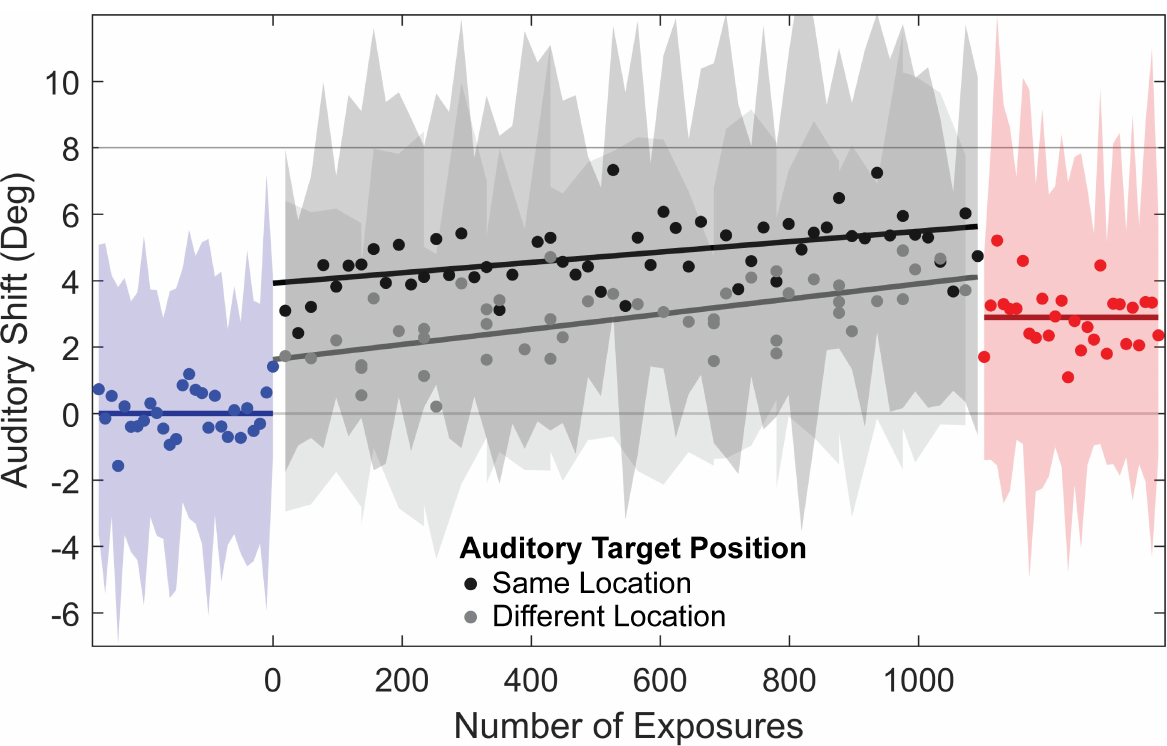
Fig 3. Evolution of auditory shift with repeated exposure to fixed AV disparity, averaged across subjects. Blue and red points represent average relative error for pre-disparity and post-disparity, respectively. Black and gray points represent average relative error while localizing auditory targets during the exposure block, with black indicating localization of auditory targets presented 1–3 seconds after and 0˚ away from the auditory component of the AV disparity (“same location” targets), and gray indicating localization of targets presented more than 8 seconds after and at a different location than the auditory component of the AV disparity (“different location” targets). Blue and red lines indicate mean average relative error in the pre and post disparity blocks (with auditory shift defined relative to the pre-disparity localization responses for each session), gray lines show linear best fits to responses in the exposure block, and shaded regions represent ± 1 standard deviation across subjects for each sample of the corresponding color.